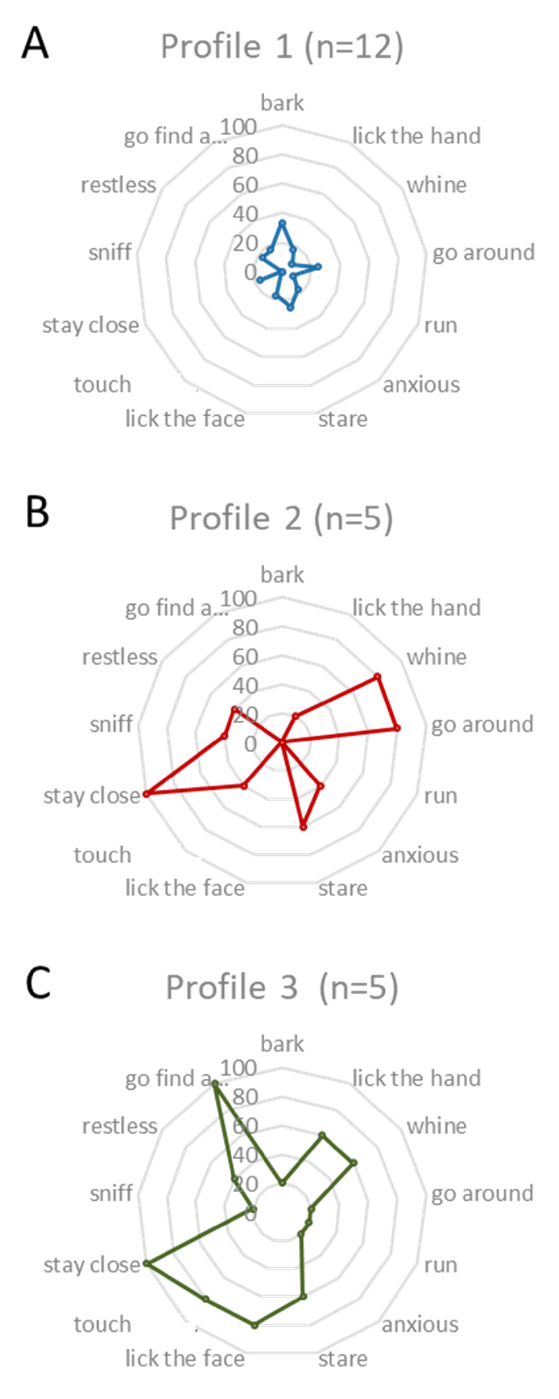
Figure 5. Behavioral profiles of seizure-alert pet dogs of ( A ) group 1 ( B ) group 2 and ( C ) group 3 obtained after a cluster analysis.